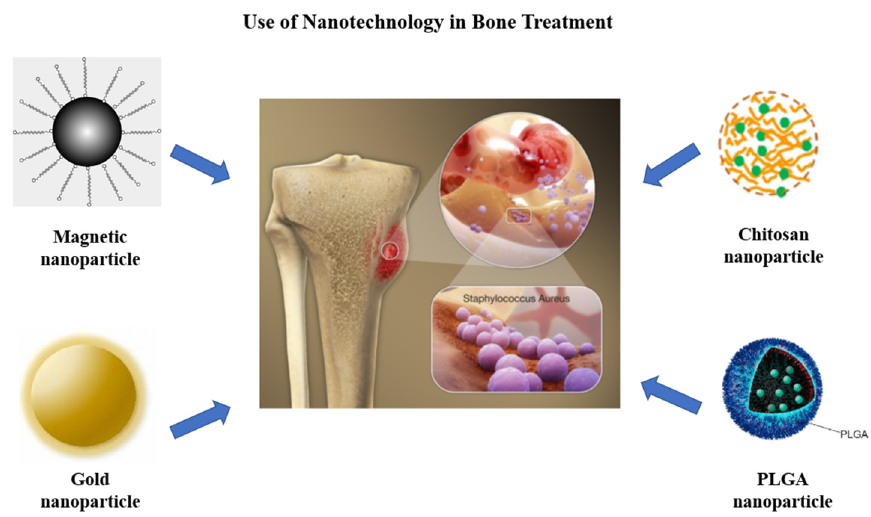
Figure 6. Uses of various types of nanoparticles in the treatment of osteomyelitis. Created with Bi- oRender.com